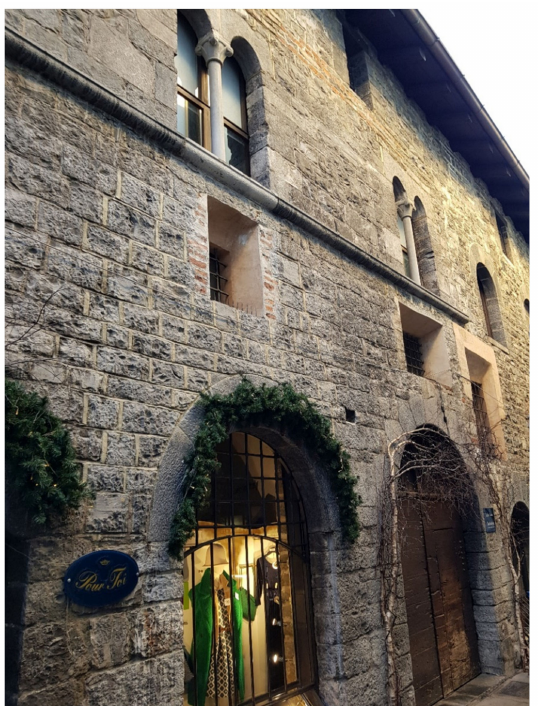
Figure 5. Como, Facade of Casa Bazzi, photo captured by S. Della Torre in